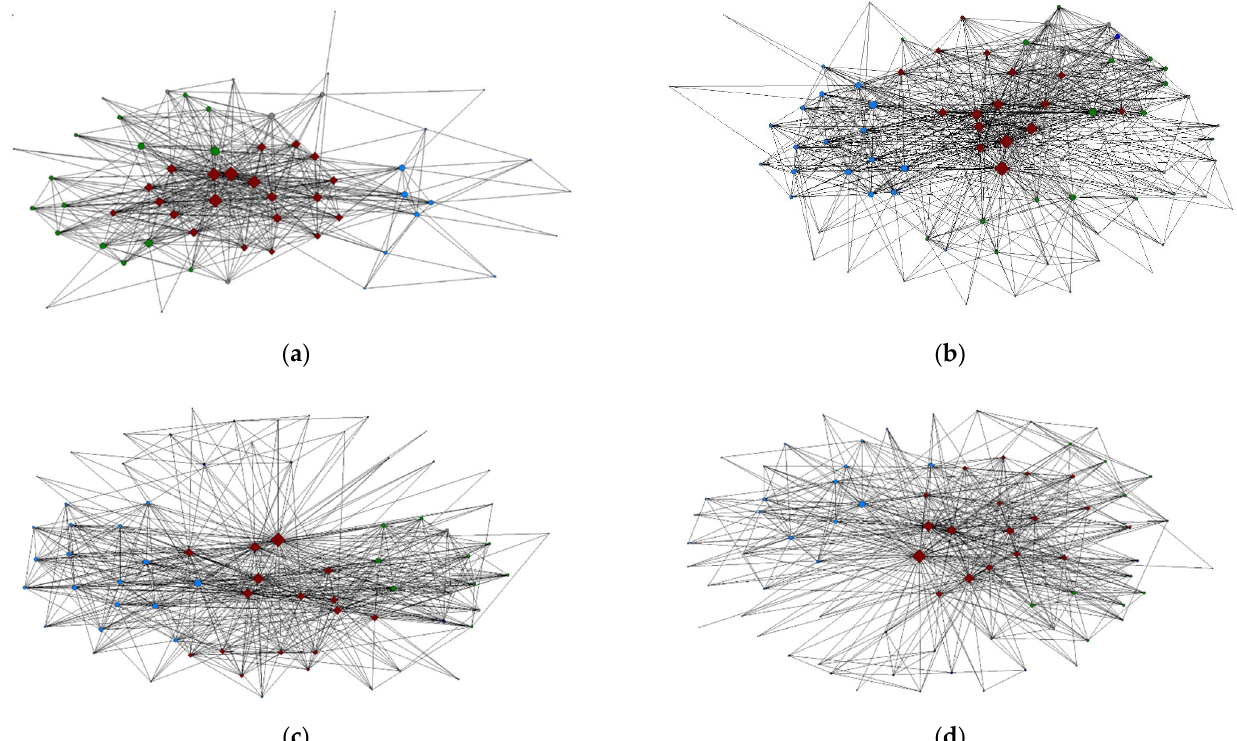
Figure 3. Evolution of the NEC network sociograms over grant Cycle 1 and 2. ( a ) Any contact, Cycle 1 Year 1. ( b ) Any contact, Cycle 1 Year 4. ( c ) Any contact, Cycle 2 Year 1. ( d ) Any contact, Cycle 2 Year 4. [LEGEND: Node size: centrality by degree (# of ties); Node color: Sector (Maroon = AgFF; Green = Agriculture; Light blue = Fishing; Dark blue = Forestry; Gray = Other (General Occupational Health); Node shape: Diamond = Intramural NEC staff; Circle = Extramural non-NEC].